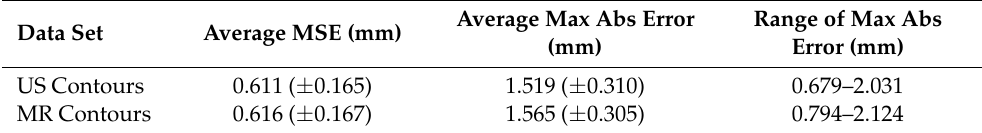
Figure 3. Input clinician contour points and resulting 3D prostate contour model curves. Table 1. Prostate model fitting